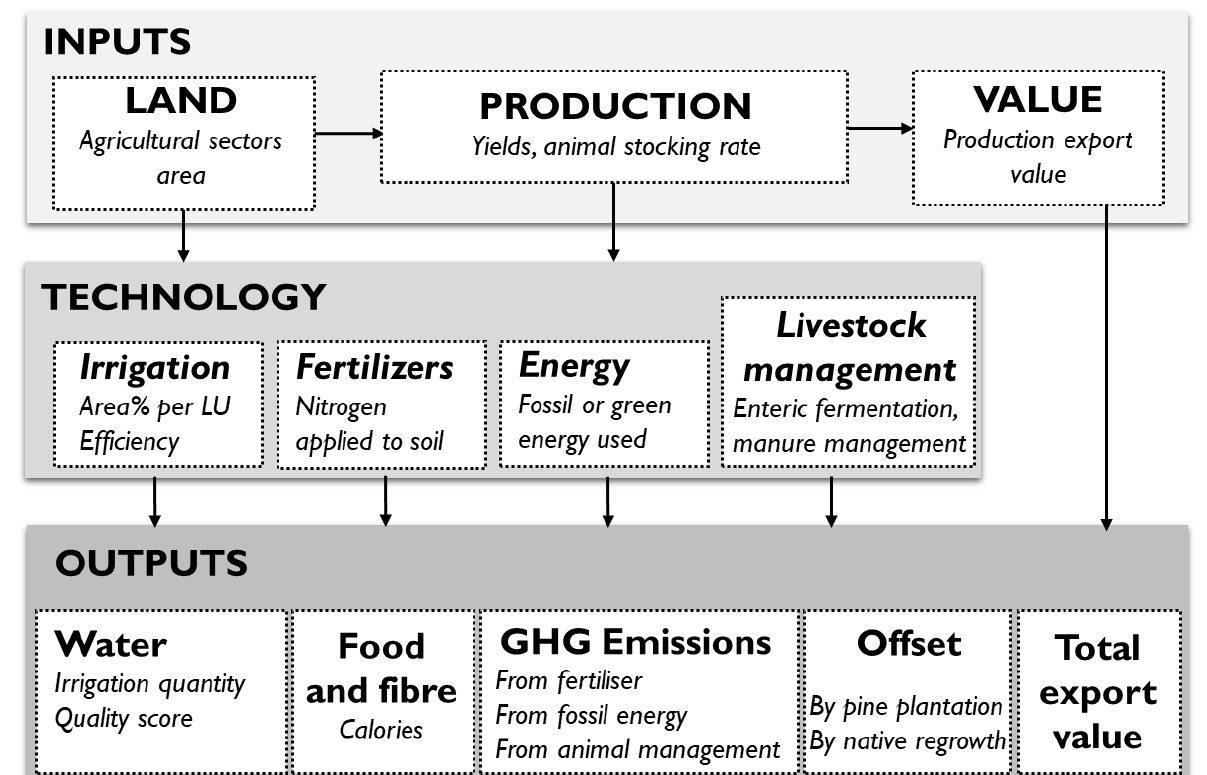
Figure 2. Model flowchart consisting of inputs, technology parameters, and computed outputs.